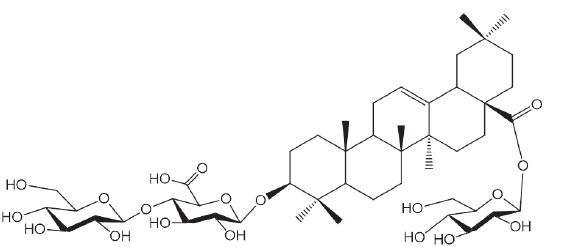
Figure 1 - The structure of saponin